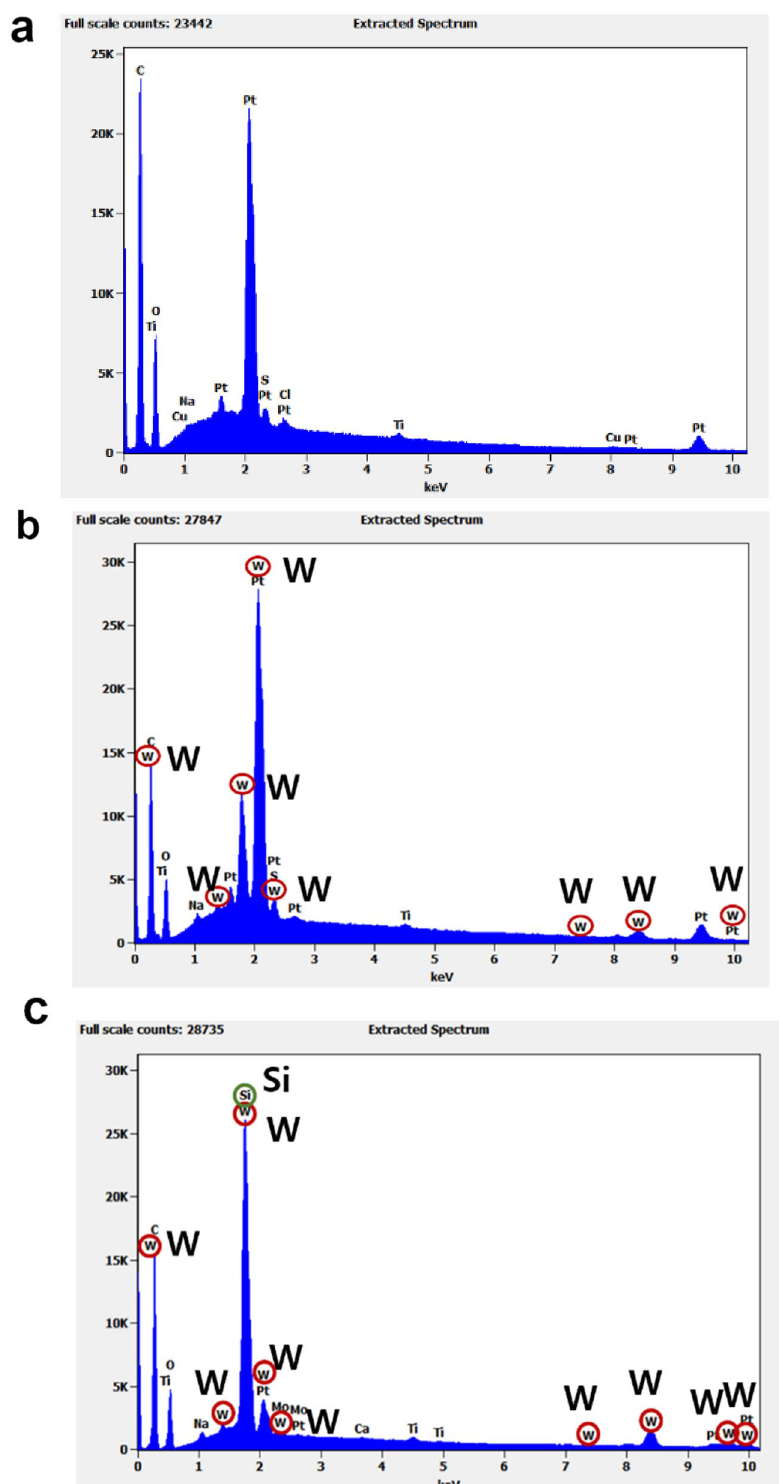
Fig. 4 Energy dispersive X‑ray spectroscopy (EDS) analysis of PET fabric a before treatment with tungsten bronze nanorods (TBNRs), b after treatment with TBNRs, and c after treatment with TBNRs and